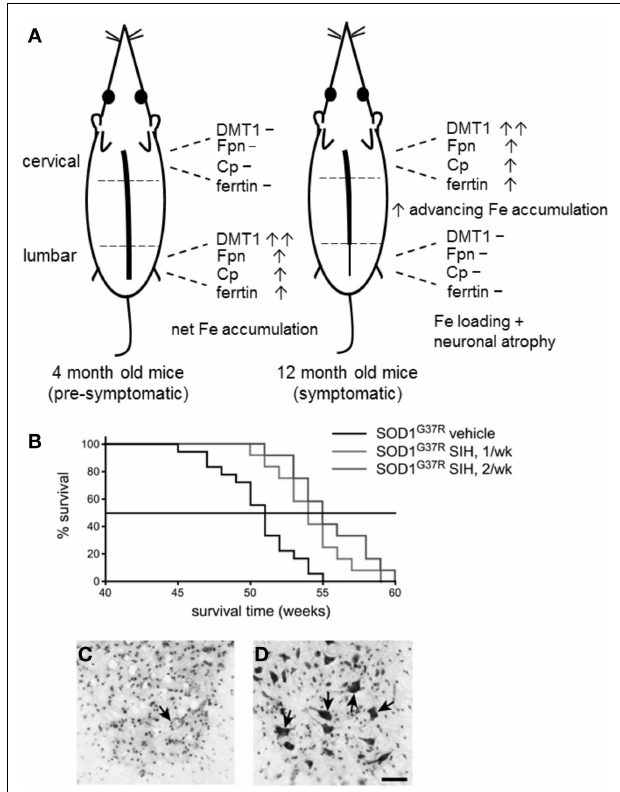
FIGURE 2 | (A) The caudal-to-rostral (tail-to-head) pattern of mRNA expression of iron metabolism proteins in young and old SOD-1(G37R) mice provides circumstantial evidence that Fe is involved in the neurodegenerative process. Advanced neurodegeneration and Fe loading is evident in the lumbar region 12-month-old mice, where 8months earlier, the expression pattern of proteins of Fe metabolism favored net Fe accumulation. (B) Treatment of SOD-1(G37R) mice with the Fe chelator SIH extends lifespan in SOD-1(G37R) mice. SOD-1(G37R) mice were given SIH either once or twice a week ( n = 12) from 8months of age, a Kaplan–Meier graph shows the percentage of animals surviving with age. (C,D) Vehicle control treated 50 week-old SOD-1(G37R) mice showed loss of neurons whereas SIH treatment results in neuronal preservation (arrows) as indicated by cresyl violet-stained lumbar spinal cord tissue sections. Scale bar, 50 µ M. [ (B–D) reproduced with permission and minor modification from Jeong et al.,